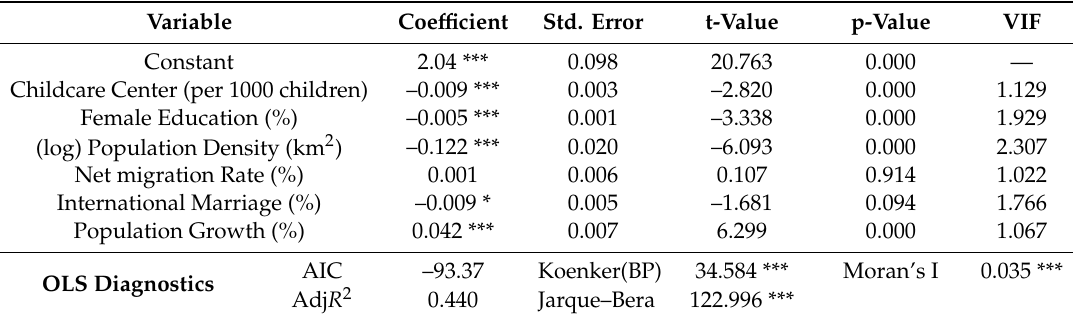
Table 2. Summary of Ordinary Least Squares (OLS)